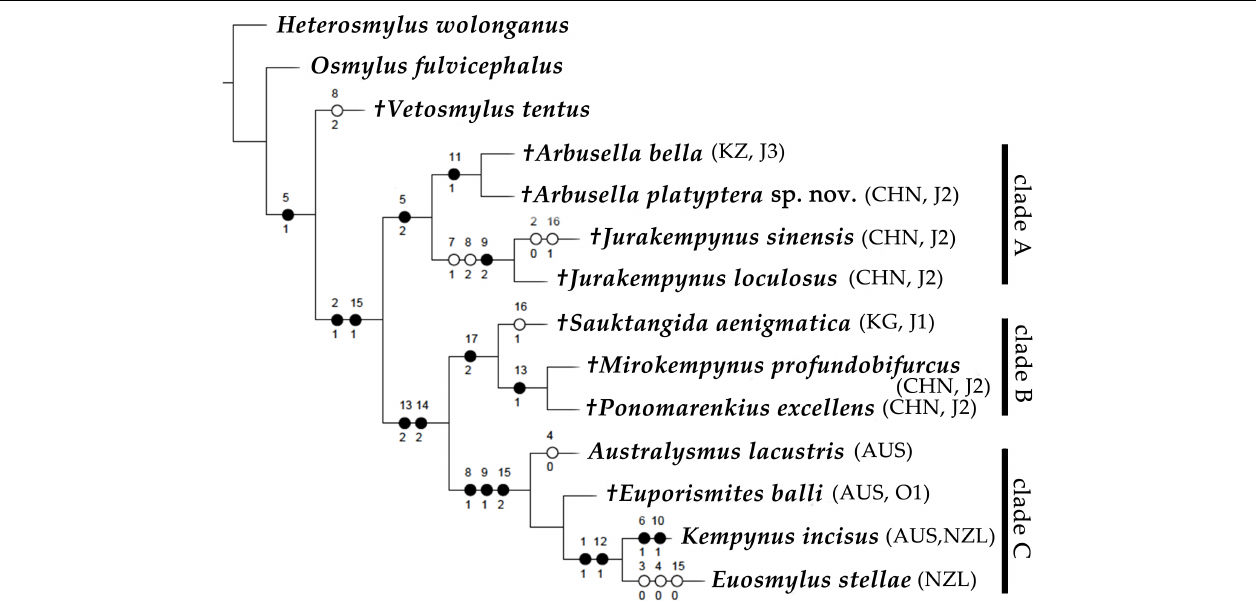
FIGURE 2 | Most parsimonious tree of Kempyninae from phylogenetic analyses (tree length = 35 steps; consistency index, CI = 0.74; retention index, RI =